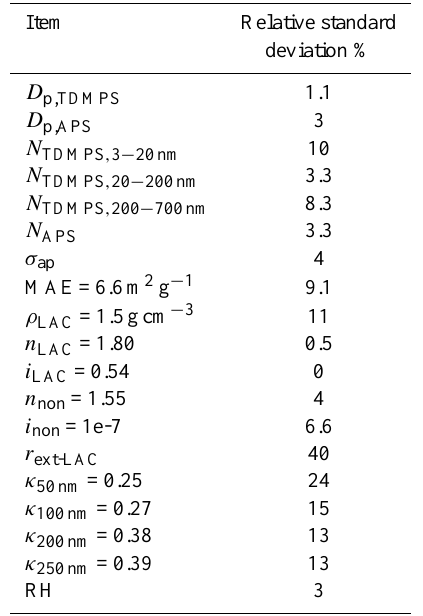
Table 3. The standard deviation of ω ( σ ω ), the rate of change of ω (cid:16) dω (cid:17) and the contribution of RH to the uncertainty of with RH d RH